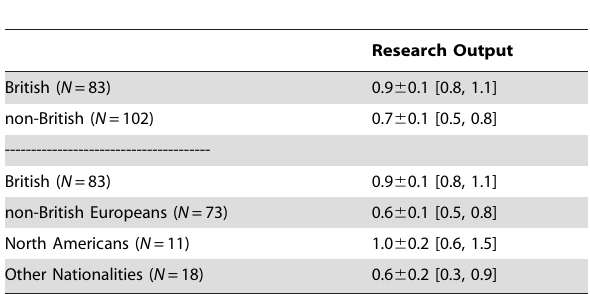
Table 2. PDRs research output according to their nationality: mean 6 standard error and 95% confidence interval (brackets).